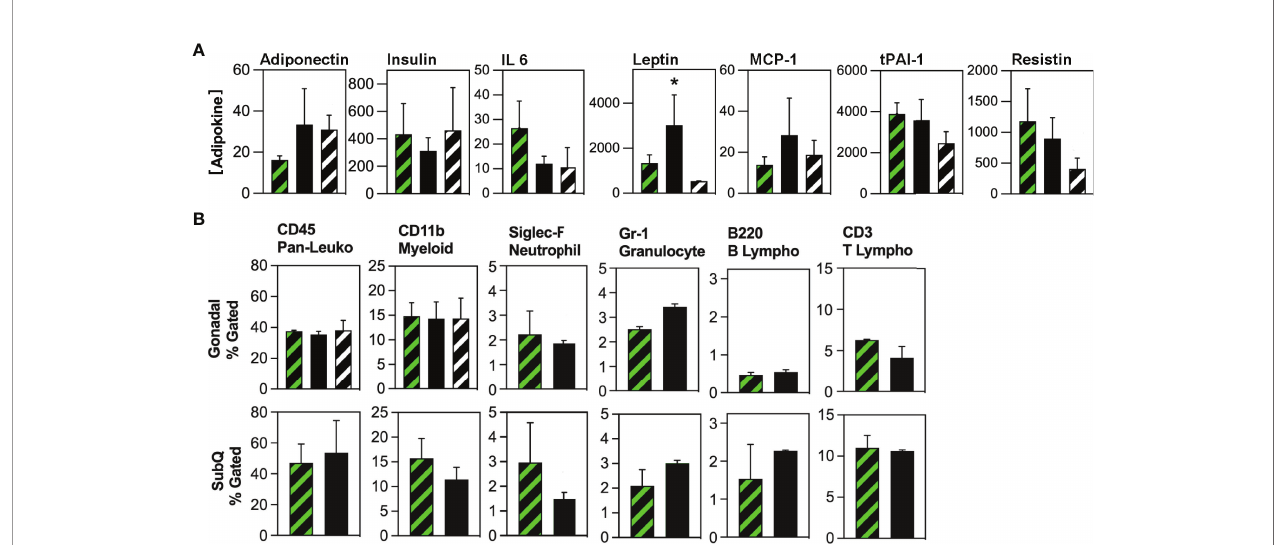
FIGURE 5 | Evaluation of circulating adipokine and adipose tissue-resident immune cell populations in Competent and Ablated mice. (A) Circulating adipokine levels were measured in the serum of transplant-naïve (black/white crosshatch bars), Competent (black/green crosshatch bars) and Ablated (solid black bars) mice with Luminex Adipokine Assay reagents, except adiponectin which was measured separately with Luminex Adiponectin Assay reagents. Adiponectin levels are reported in µg/ml, while all other cytokine levels are reported in pg/ml. (n=3 per cohort, * indicates p ≤ 0.05) (B) Adipose tissue-resident immune cell populations indicated above each plot were quanti fi ed by fl ow cytometry in the gonadal and subcutaneous (SubQ) fat from transplant-naïve (black/white crosshatch bars)Competent (black/green crosshatch bars) and Ablated (solid black bars) mice. (n=3 per cohort, * indicates p ≤